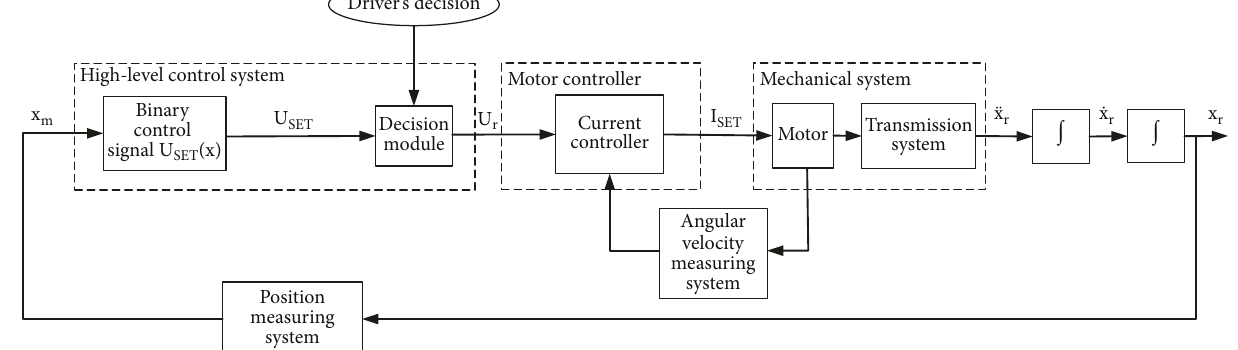
Figure 6: Drive system diagram: control scheme A.